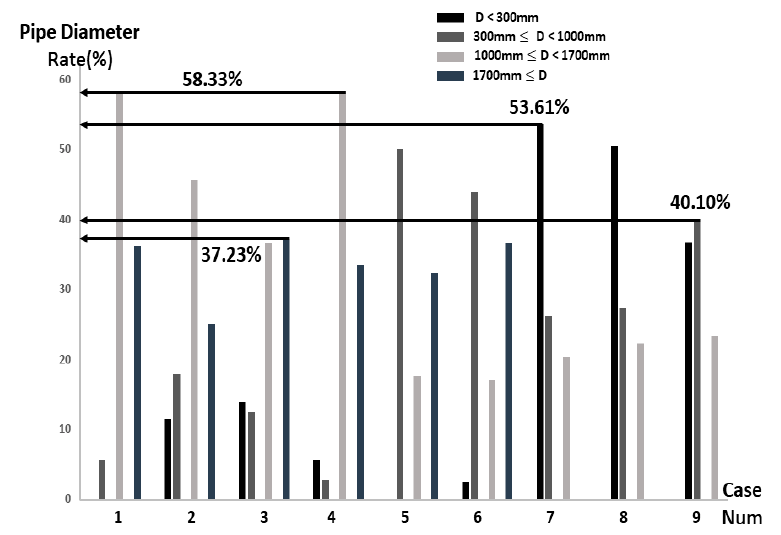
Figure 5. Distribution of Pipe Diameter in Each Critical Path.